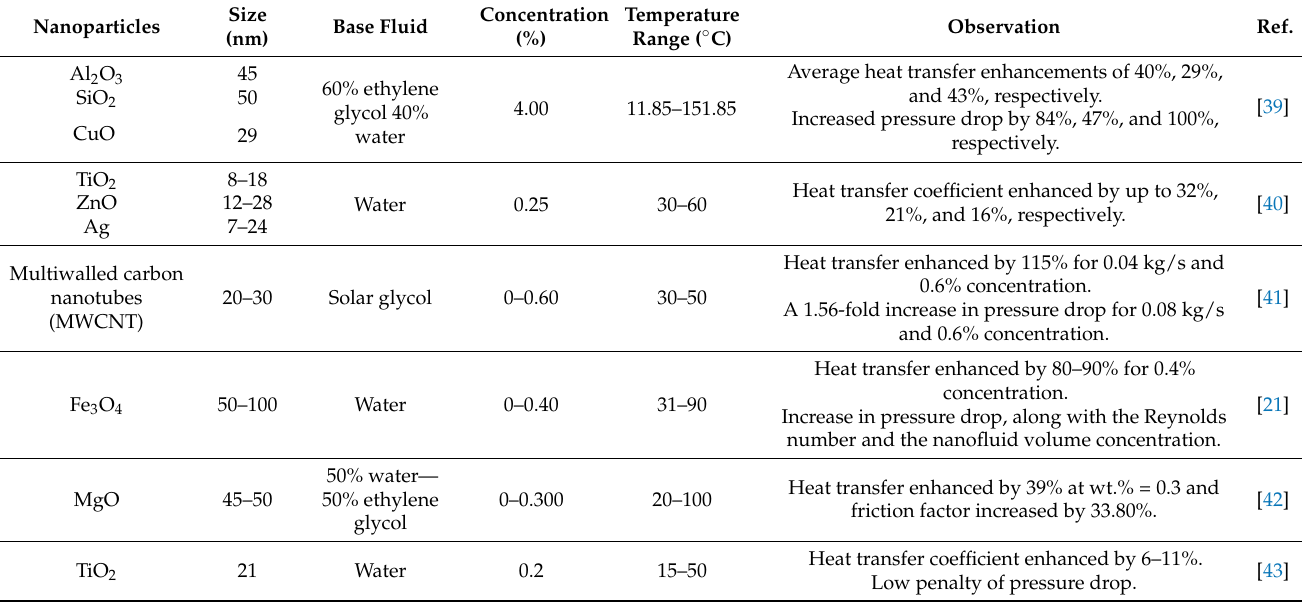
Table 2. Formed nanofluids commonly used in the enhancement of double-pipe heat